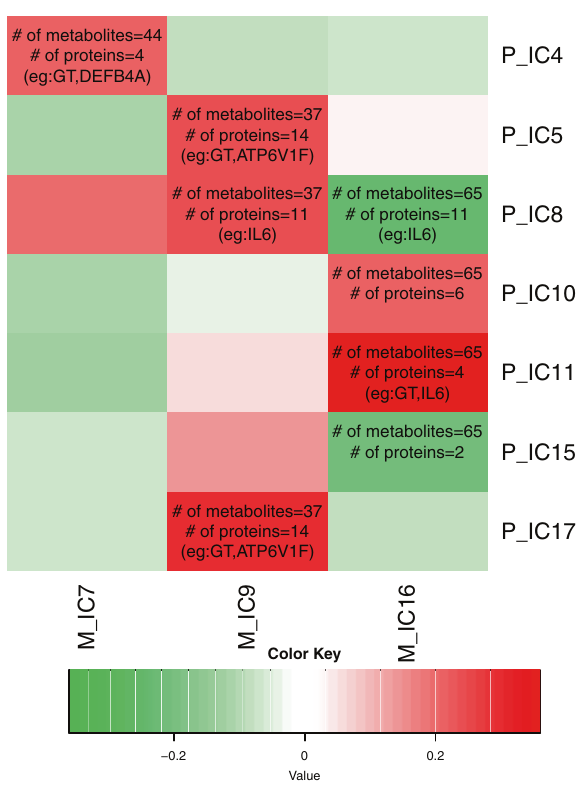
Fig. 3 Heatmap depicting the correlations among the 3 metabo- lomic modules signi fi cantly associated with PTSD status and 7 proteomic modules which are correlated with these 3 metabo- lomic modules. The correlations with p < 0.05 corresponded to the cell with